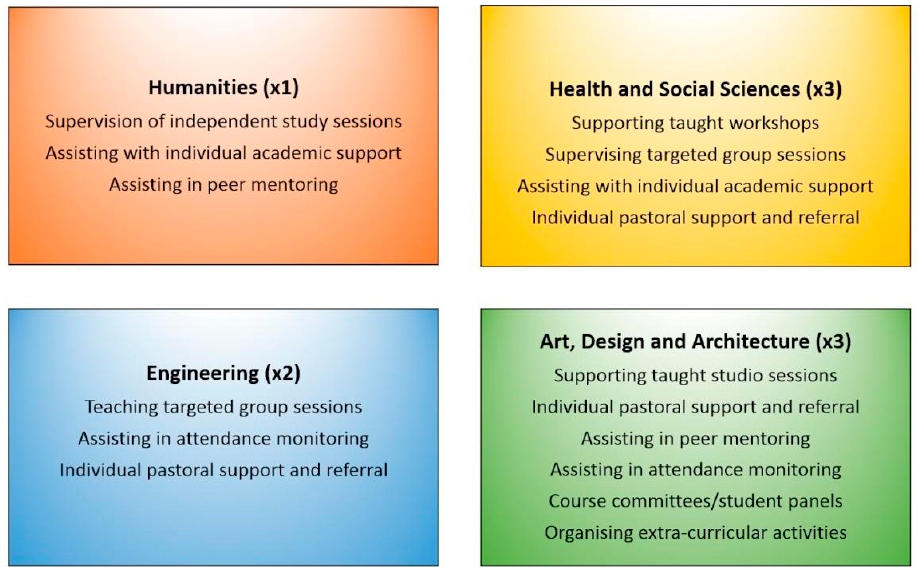
Figure 1. Graduate Teaching Assistant (GTA) activities in different Schools.